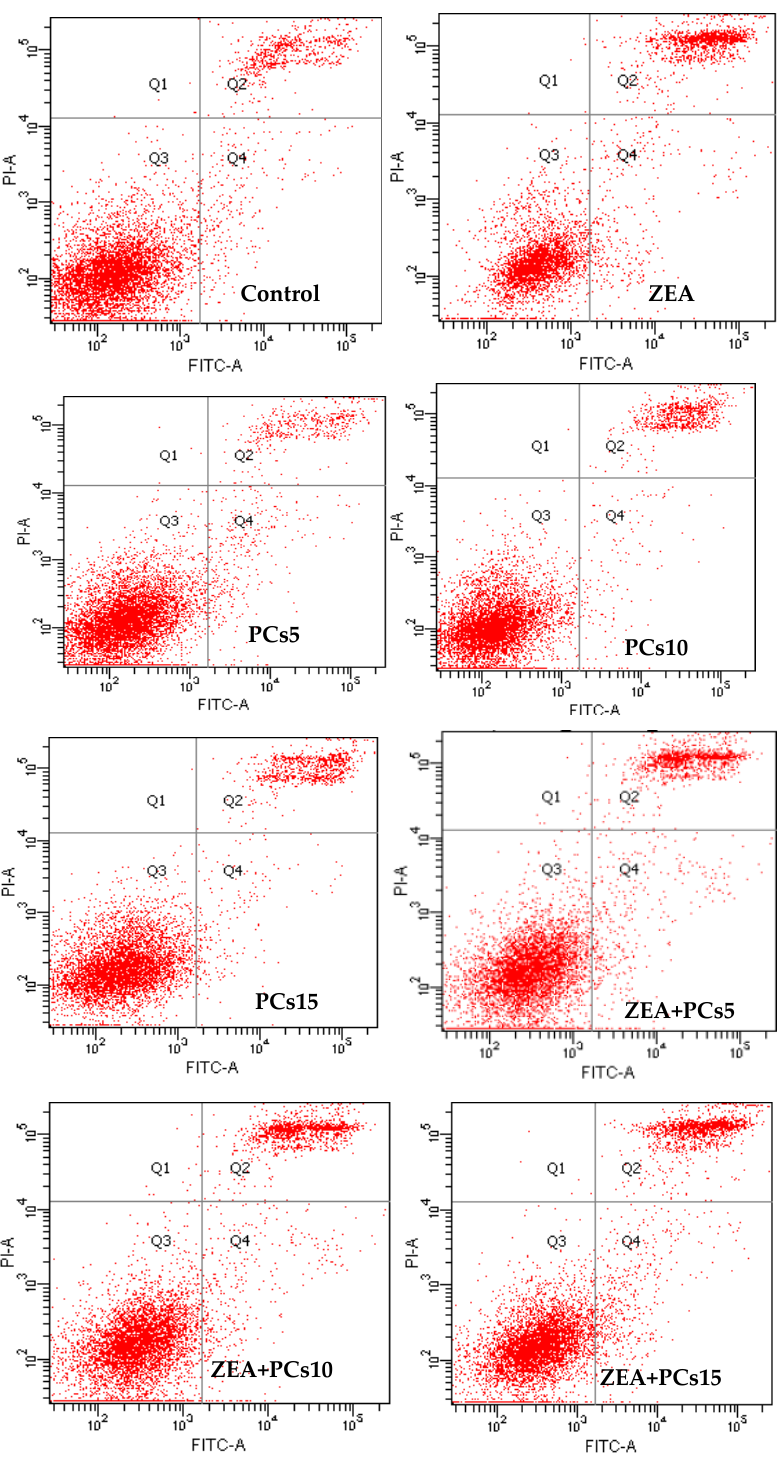
Figure 4. Effect of proanthocyanidins (PCs) on the apoptosis of the MODE-K cells exposed to zearalenone (ZEA).